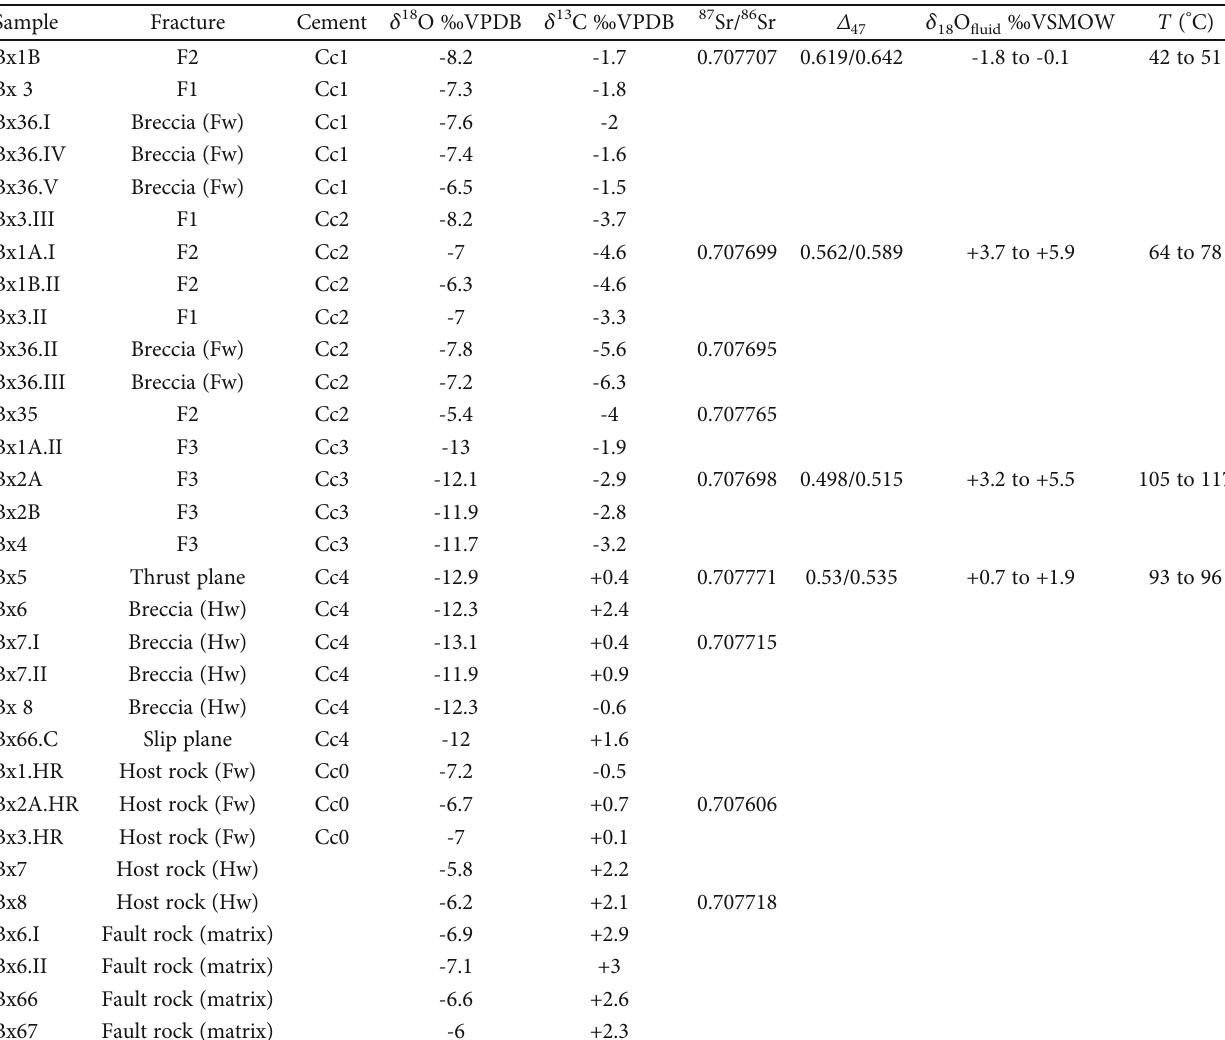
Table 1: δ 18 O, δ 13 C, and 87 Sr/ 86 Sr isotopic signature of the calcite cements, fault rocks, and host rocks. The Δ temperatures obtained from clumped isotopes are also included. Fw means footwall and Hw means hanging wall.